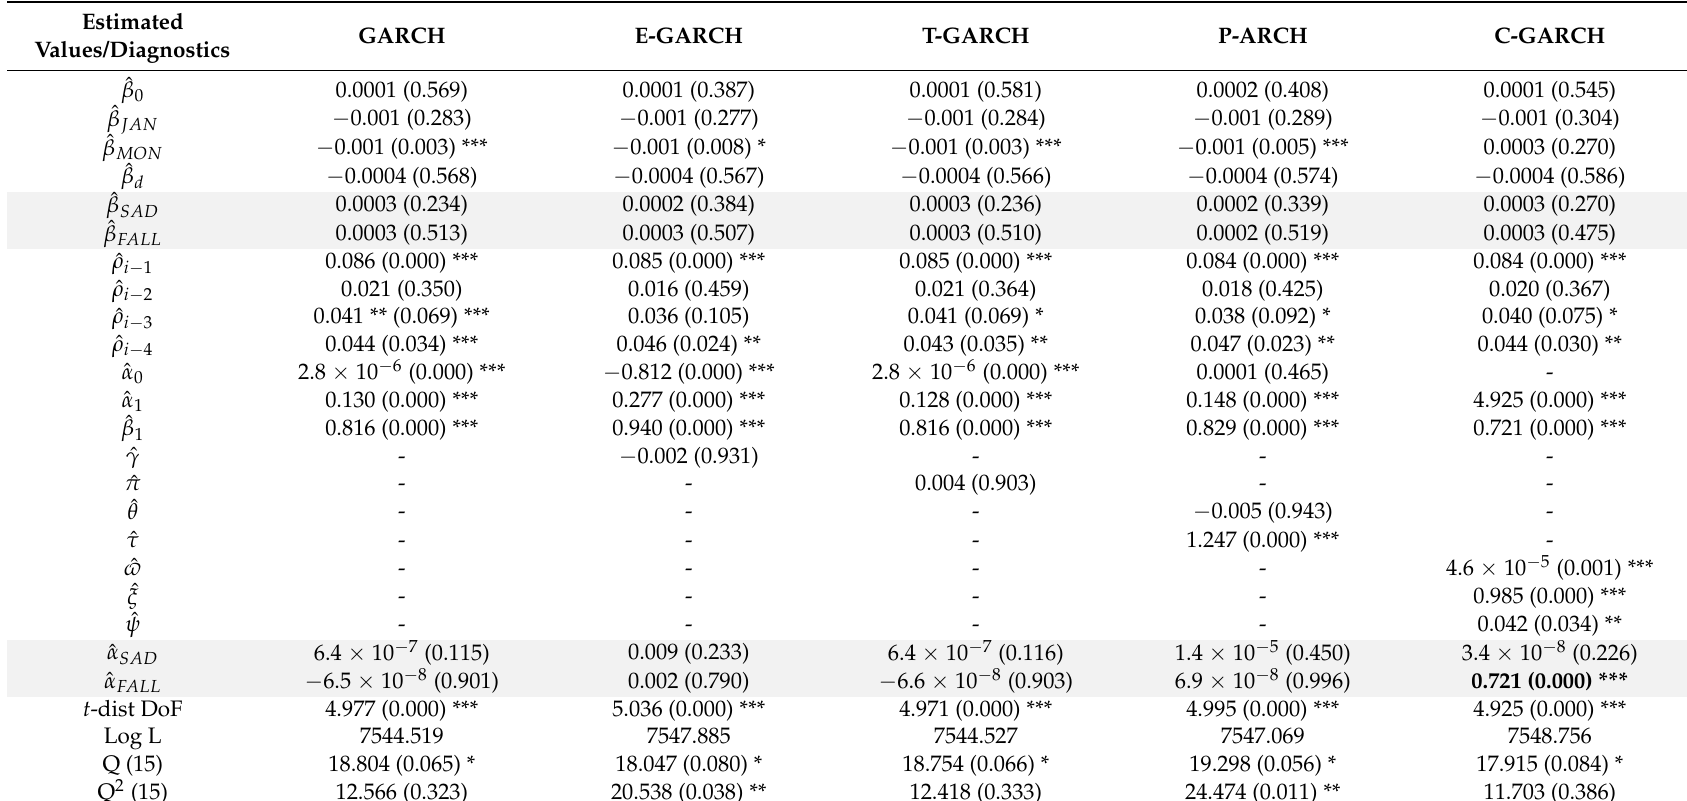
Table A1. Different GARCH specifications for